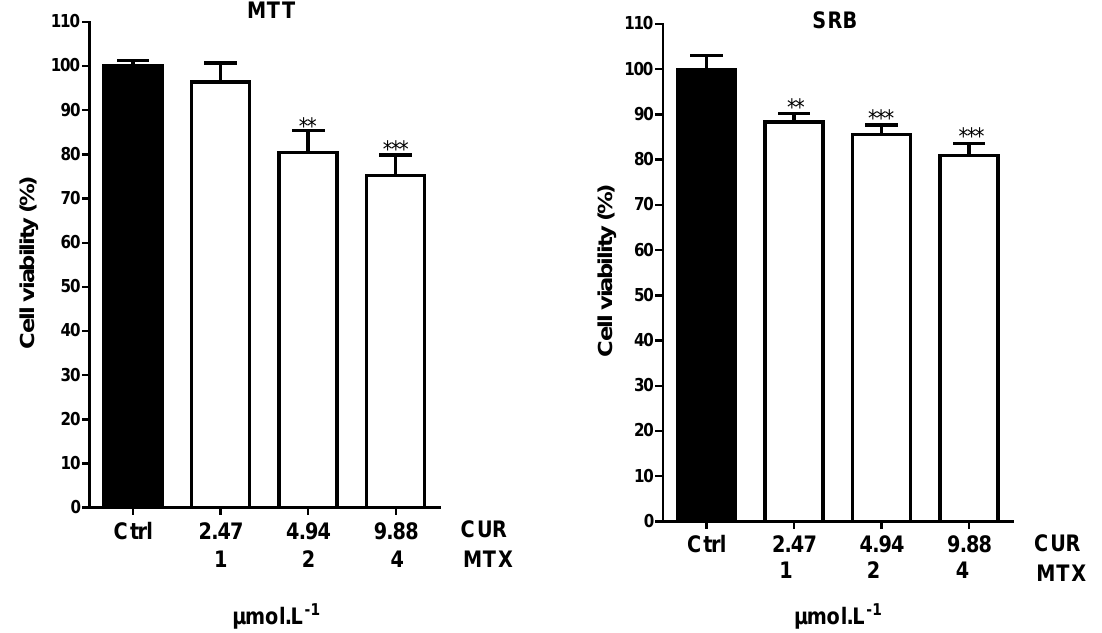
Figure 5. Cell viability of Calu-3 by MTT and SRB assays after its treatment with NCUR/MTX-2 at different (low) concentrations for 72 h. Results are expressed as mean ± standard error of the mean from 4 independent experiments. Asterisks denote significance levels compared to control: significantly different, ** p < 0.001 and *** p < 0.0001.